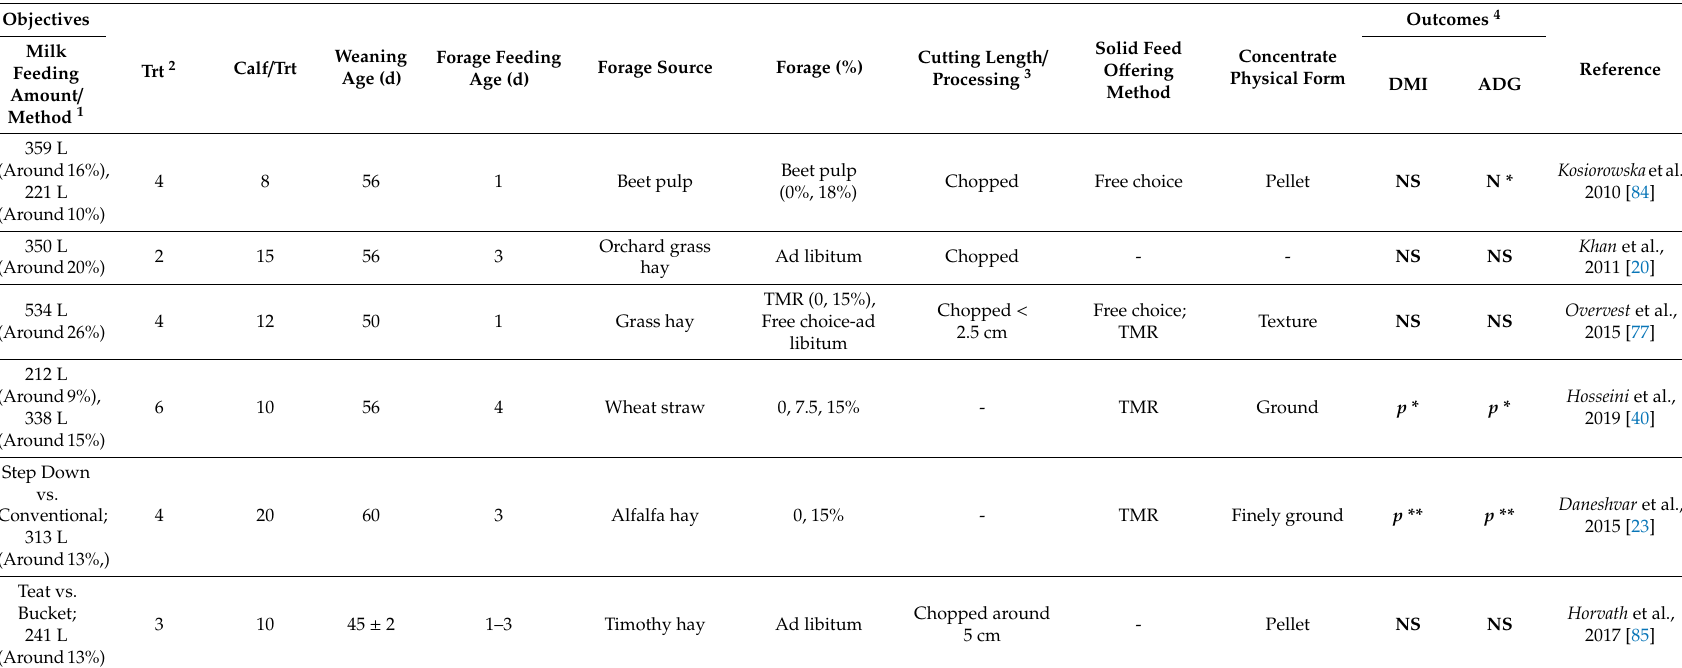
Table 6. A summary of studies on forage inclusion in dairy calves based on di ff erent volumes and methods of milk